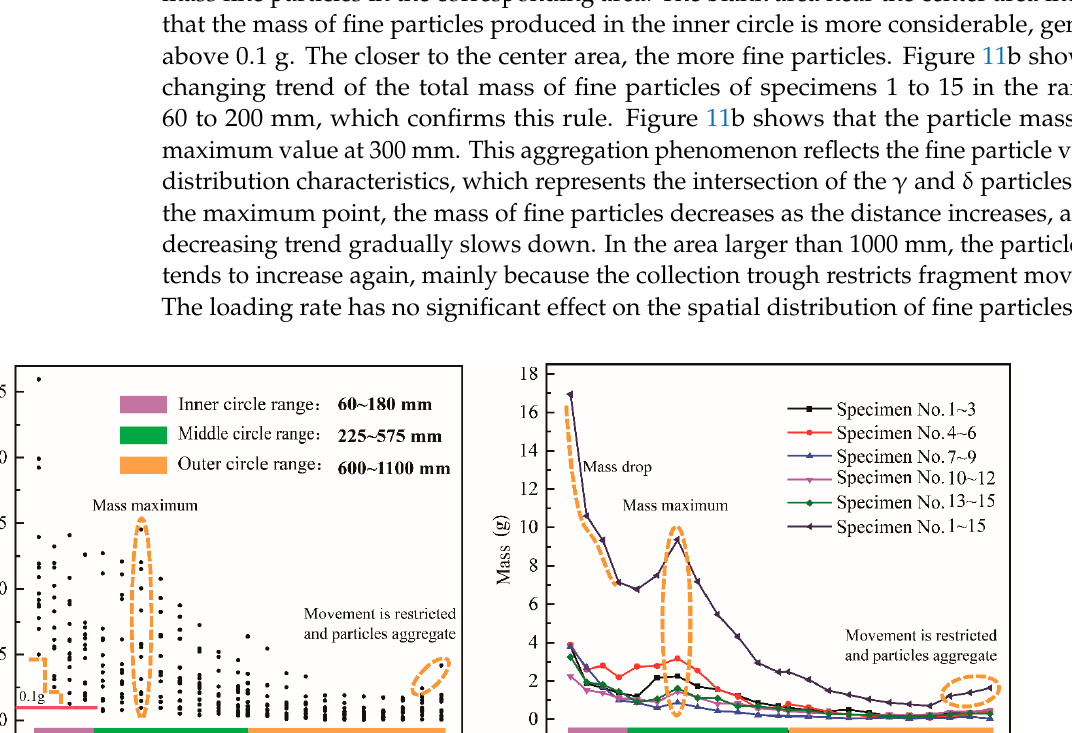
Figure 12. Spatial distribution characteristics of large particles. ( a ) Scatter plot of particle spatial distribution ( b ) Summary of particle spatial distribution of each group.